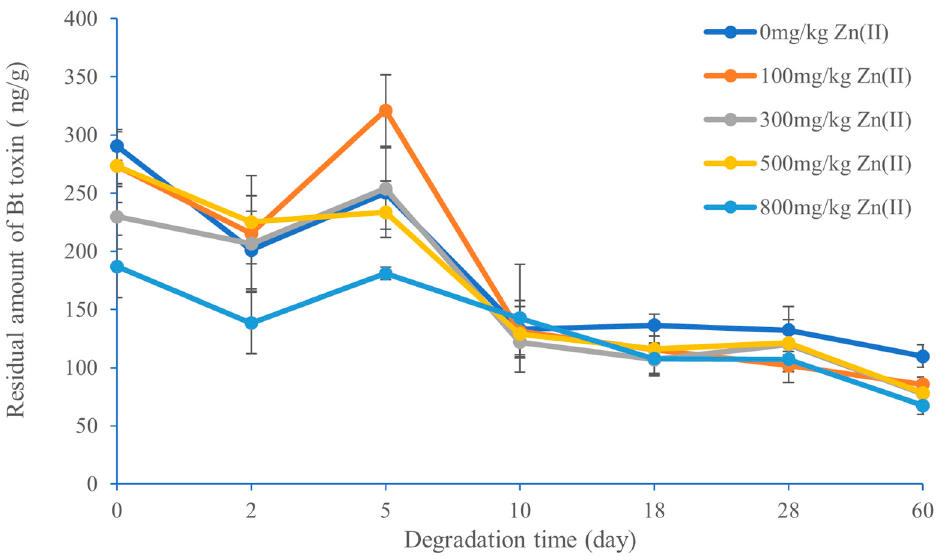
Figure 8. Effect of Zn(II) concentration on the degradation of Bt toxin in black soil.